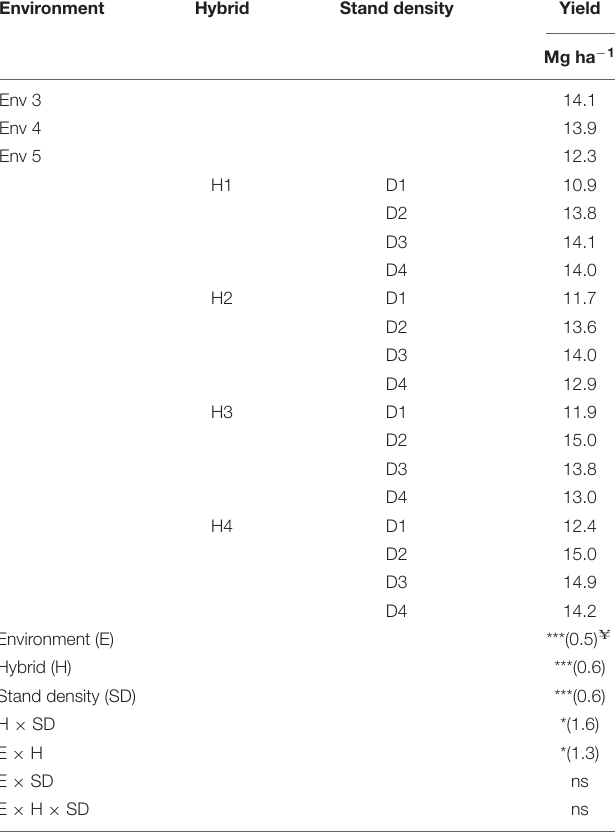
TABLE 3 | Descriptive parameters of model relating kernel number per plant (KNP) with ear biomass accumulated 15 days after anthesis (EB), and EB as a function of plant growth rate (PGR) around flowering.